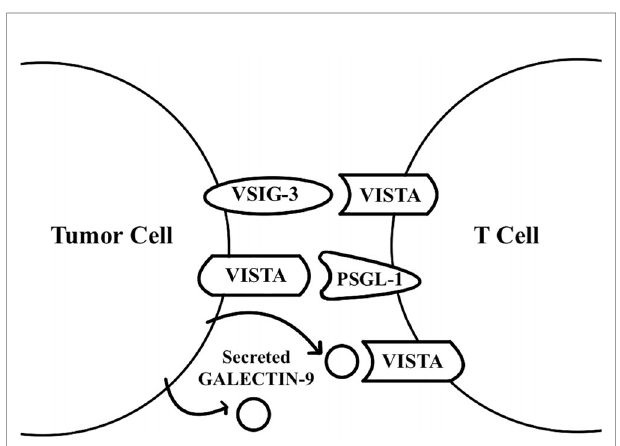
FIGURE 1 | VISTA functions as a receptor and a ligand. VISTA was found to act as a receptor on T cells for the galectin 9 and VSIG-3 ligands, and as a ligand for the PSGL-1 receptor on T